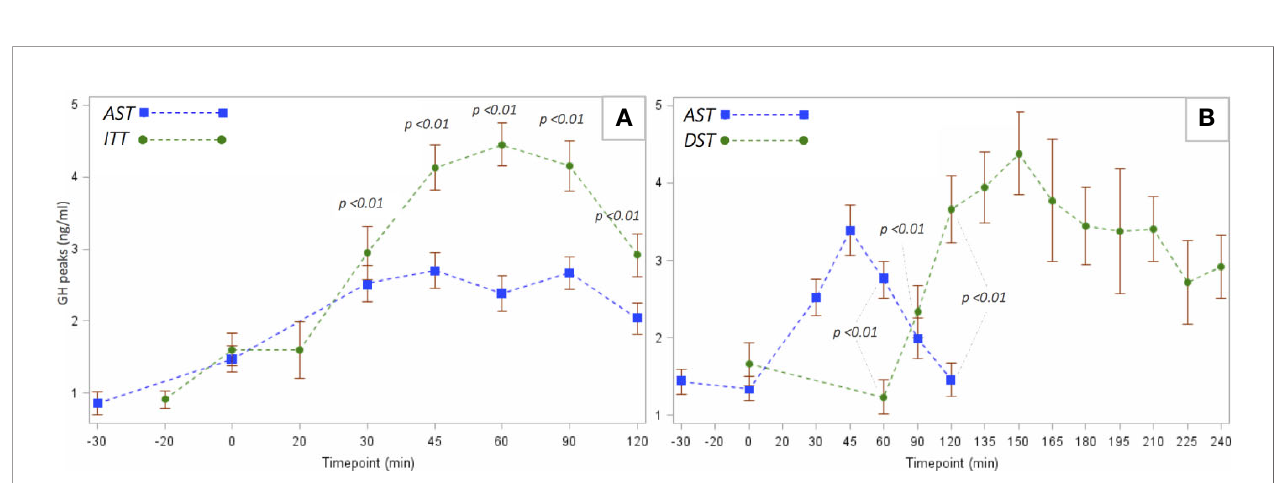
FIGURE 4 | Comparison of the mean GH values recorded at each timepoint between AST and ITT (A) and between AST and DST (B) . Bonferroni-corrected a : 0.01 for GH ITT and 0.017 for GH DST